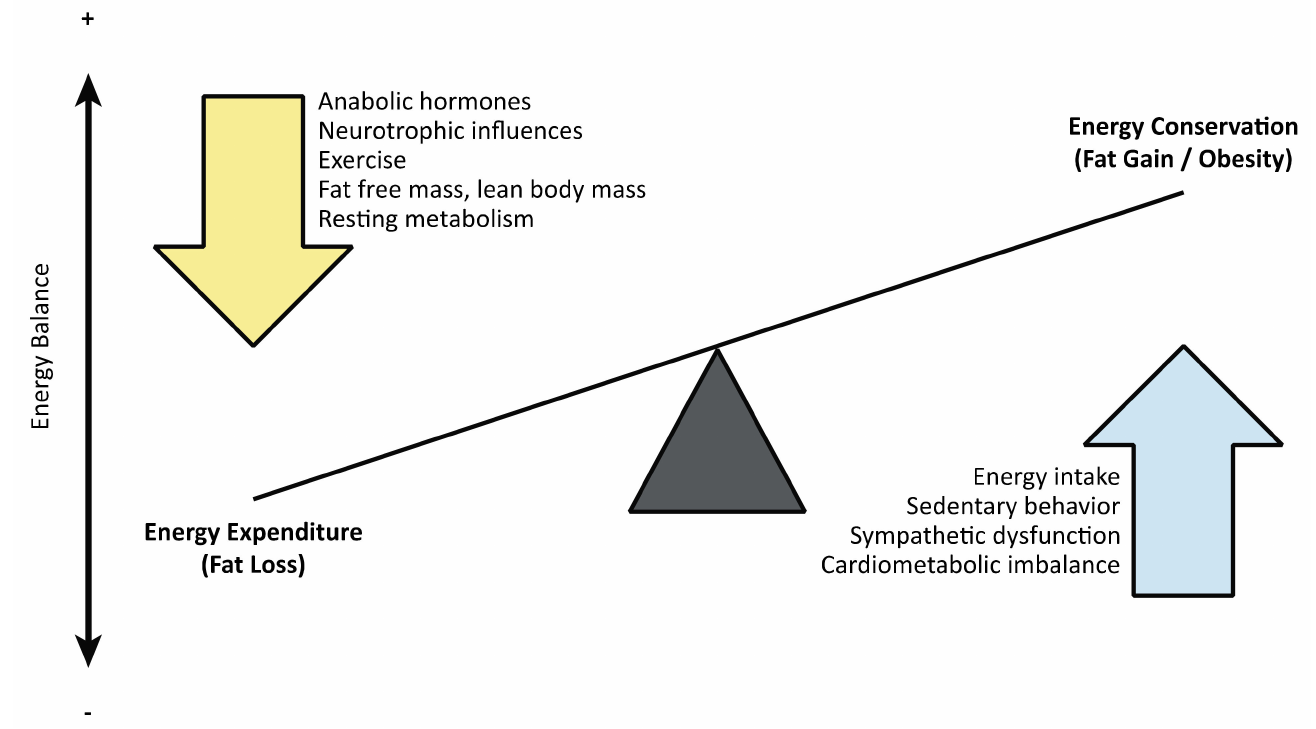
Figure 3. The relationship between energy expenditure and intake and the components influencing them following a spinal cord